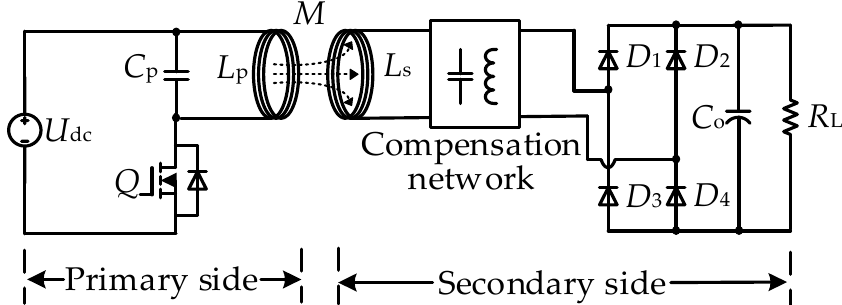
Figure 1. The topology of the single-switch circuit.